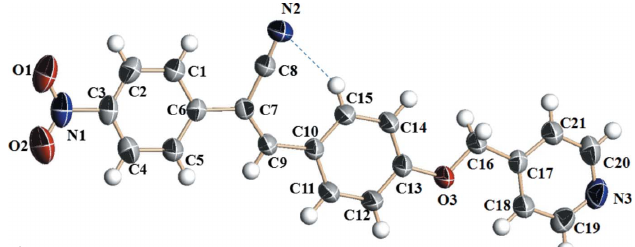
Table 2 Experimental details.